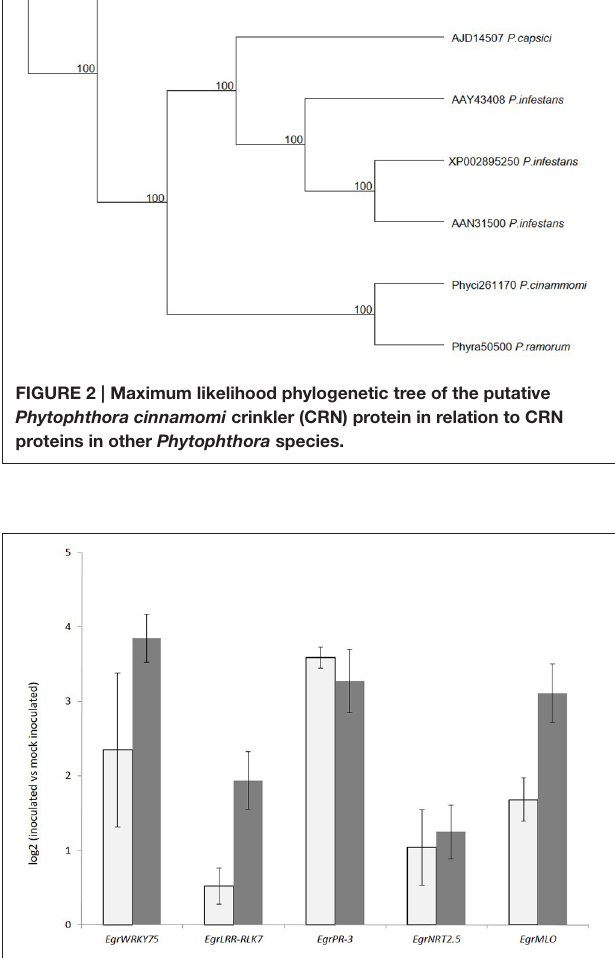
FIGURE 3 | Expression validation of selected genes in Eucalyptus nitens under Phytophthora cinnamomi inoculated compared to mock inoculated conditions 5 days post inoculation. Gray bars represent RT-qPCR expression patterns and dark gray bars, RNA-seq expression